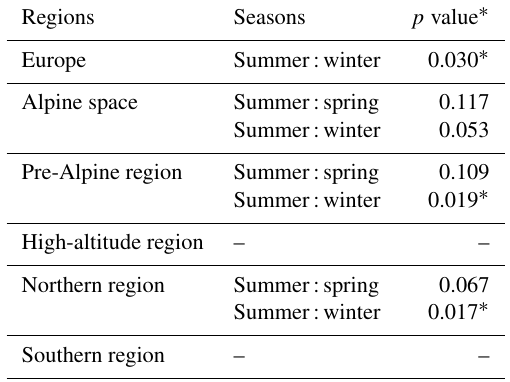
Table 2. Results with the pairwise Wilcoxon rank sum test compar- ing the central tendencies between the different seasons in all do- mains. Only combinations differing by a p value ≤ 0.15 are